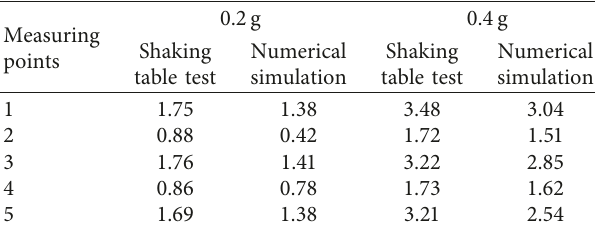
Table 4: Comparison of acceleration response peak value in the